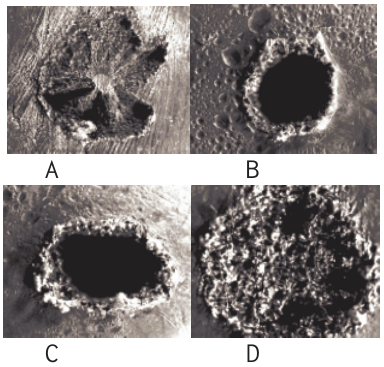
Fig. 11. Surface damage in dependence on parameter L/d.